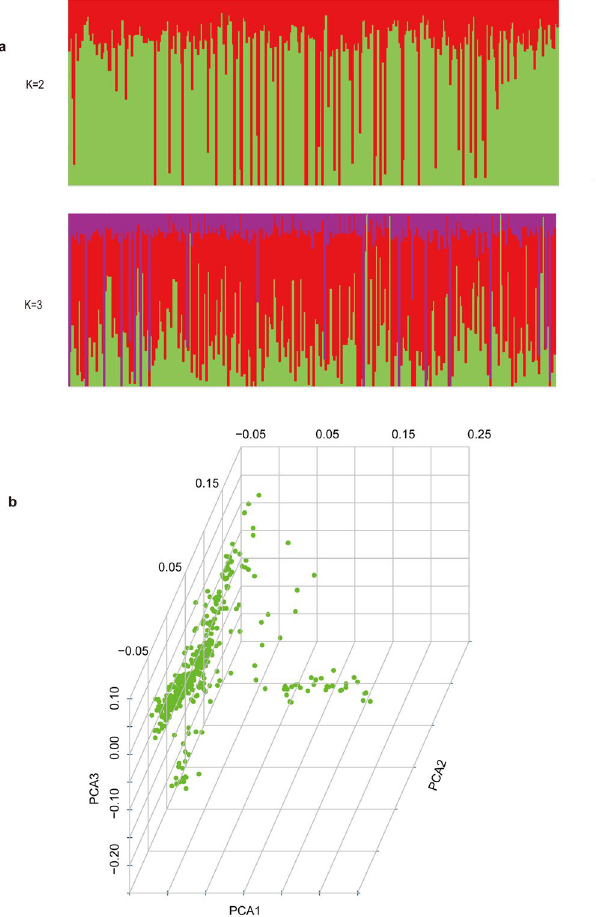
Figure 7. Population structure analysis of Inner Mongolia cashmere goat (Erlangshan). ( a ) Population structure analysis using STRUCTURE. Each sample is represented by a vertical bar. Enery color represents one ancestral population and the lenth of each colored seqment in each vertical bar represents the proportion contributed by ancestral populations. ( b ) PCA using all identified SNPs as markers. Each dots are index to samples, most samples cluster